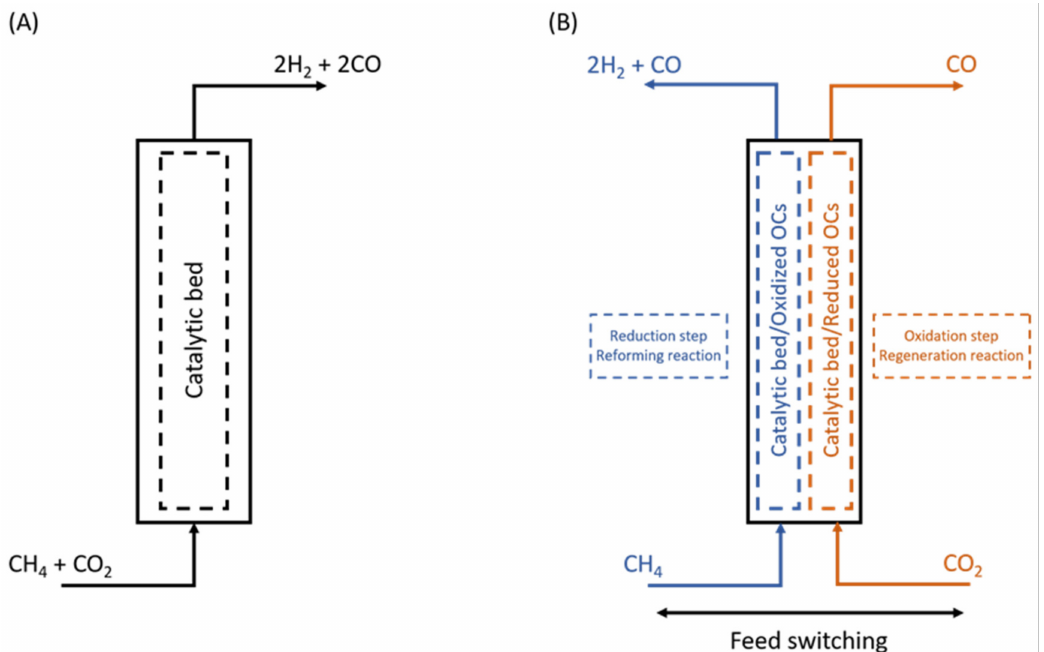
Figure 3. Schematic representation of classic co-fed DRM operation ( A ) and stepwise chemical looping DRM ( B